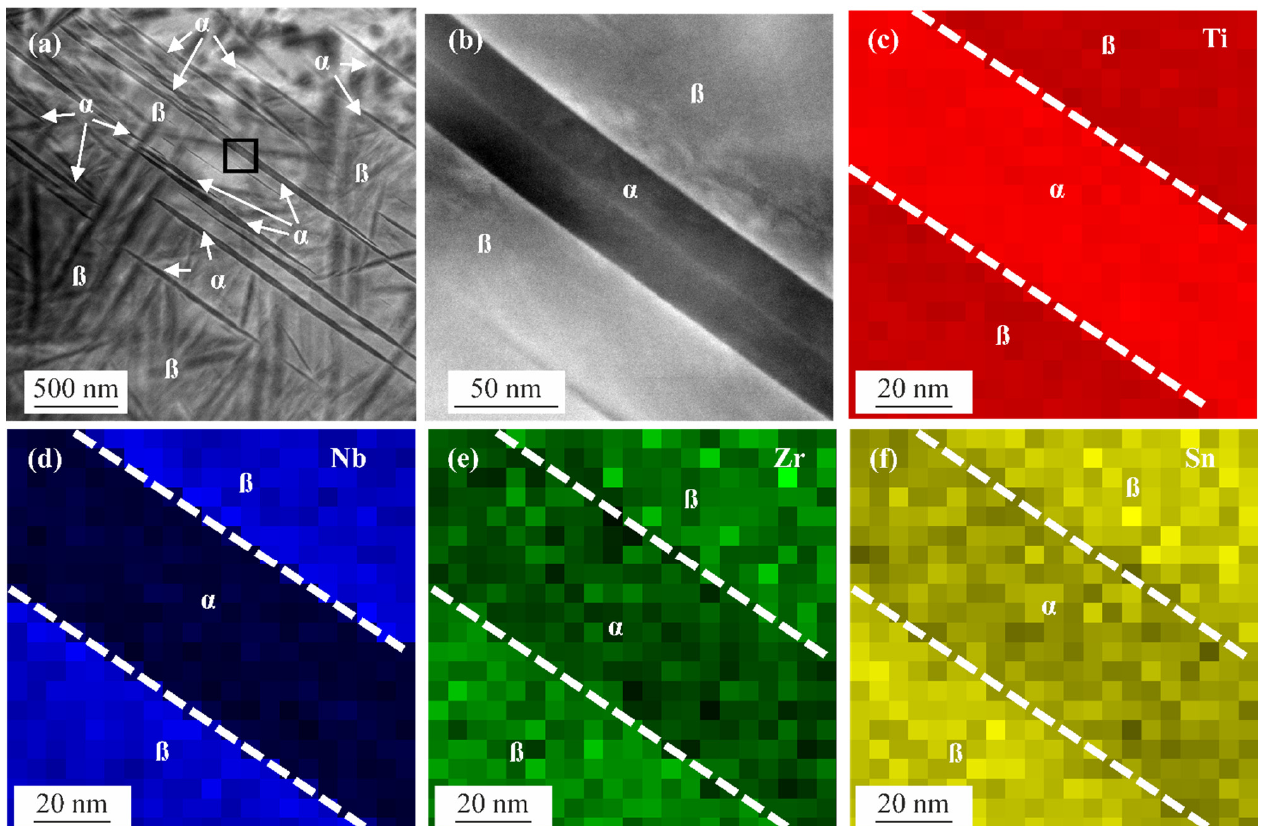
Figure 6. ( a ) HAADF STEM image of the ST+FC specimen with α phase laths inside the β phase matrix; ( b ) HAADF STEM image of the black square in ( a ), showing a higher magnification of an α phase lath surrounded by the β phase; EDS maps and chemical distribution of ( c ) titanium, ( d ) niobium, ( e ) zirconium, and ( f ) tin, demonstrating titanium enrichment inside the α phase (higher color intensity) and titanium depletion inside β phase, and enrichment of niobium, zirconium, and tin inside the β phase (higher color intensity) and depletion inside α phase, respectively.